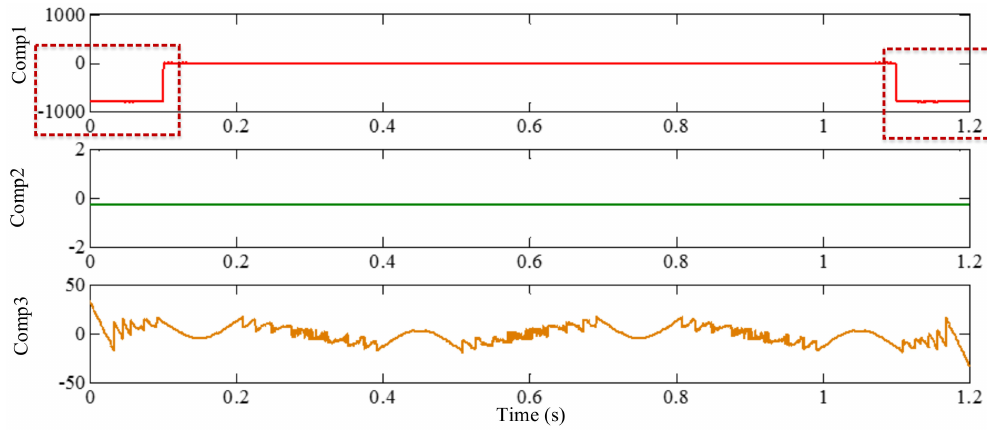
Figure 44. The IF errors of the sample signal f sig 9 obtained from the corresponding STFTs.